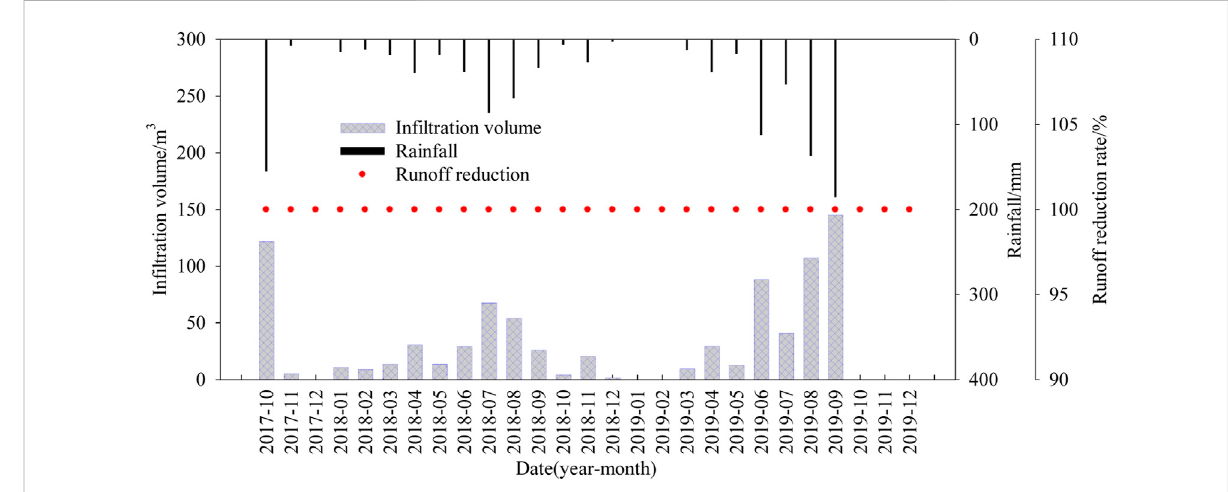
FIGURE 4 Rainfall in fi ltration and runoff reduction of